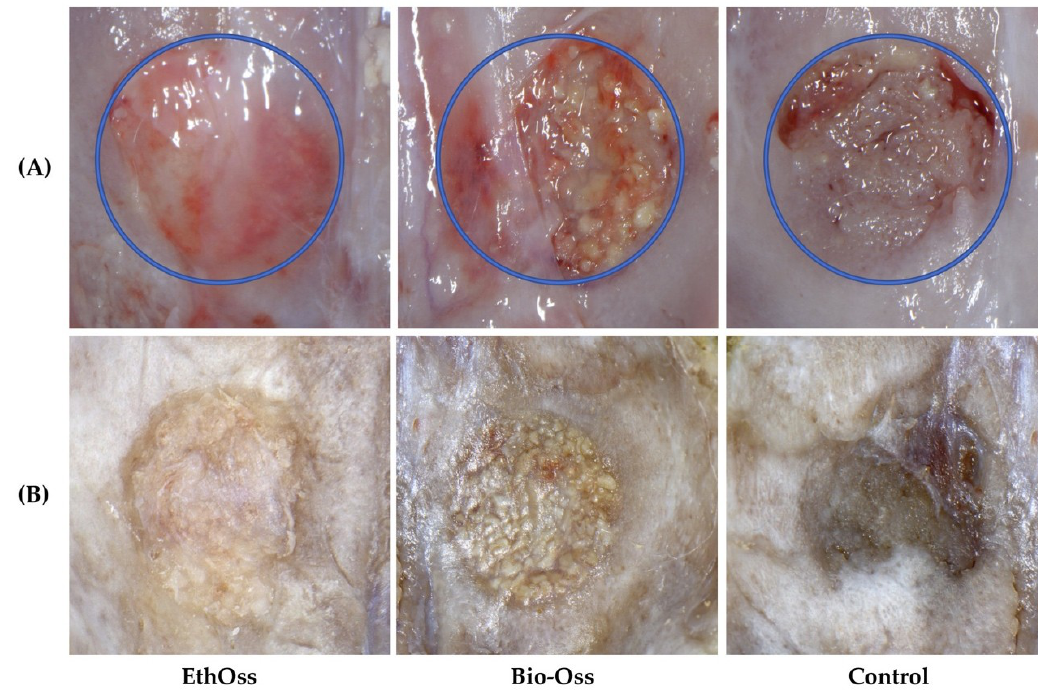
Figure 2. Gross observations of the 8-mm-diameter calvaria bone defect sites after eight weeks of healing: ( A ) fresh harvested rabbit calvaria and ( B ) after removing the dura mater and fixed in neutral buffered formalin (10%) for 24 h. Clinical observation revealed a different pattern of healing of the osseous defect between groups.